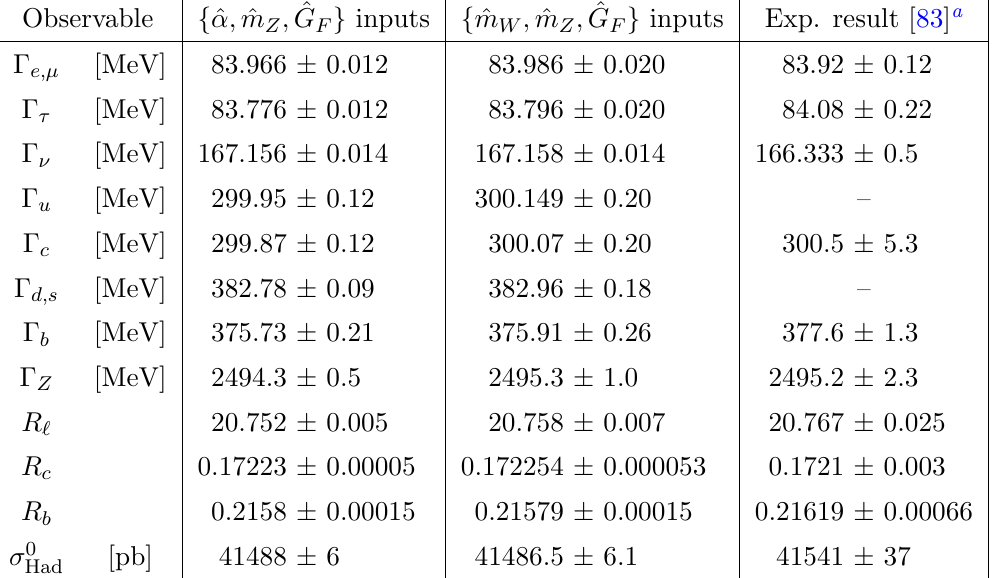
Table 2 . Predictions for LEPI observables in the two input parameter